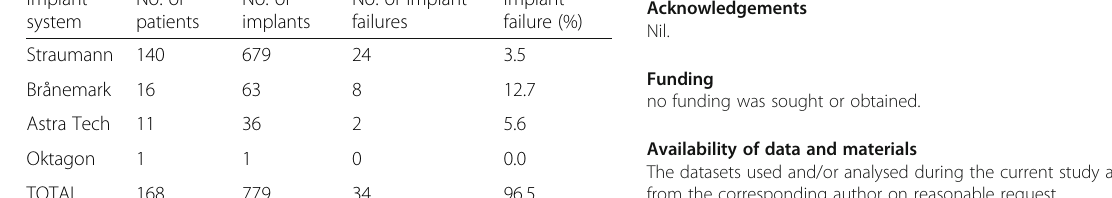
Table 9 Implant system and implant failure Implant